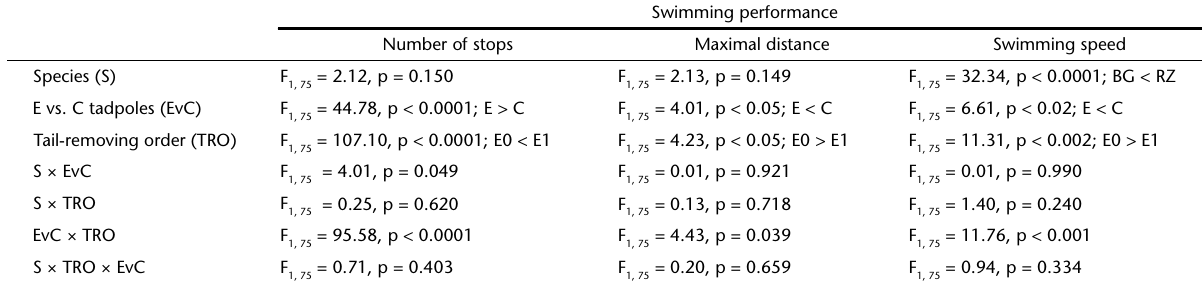
BG: B. gargarizan s ; RZ: R. zhenhaiensis . E: E tadpoles, C: C tadpoles, E0: E tadpoles initially having intact tails; E1: E tadpoles after 50% tail loss.